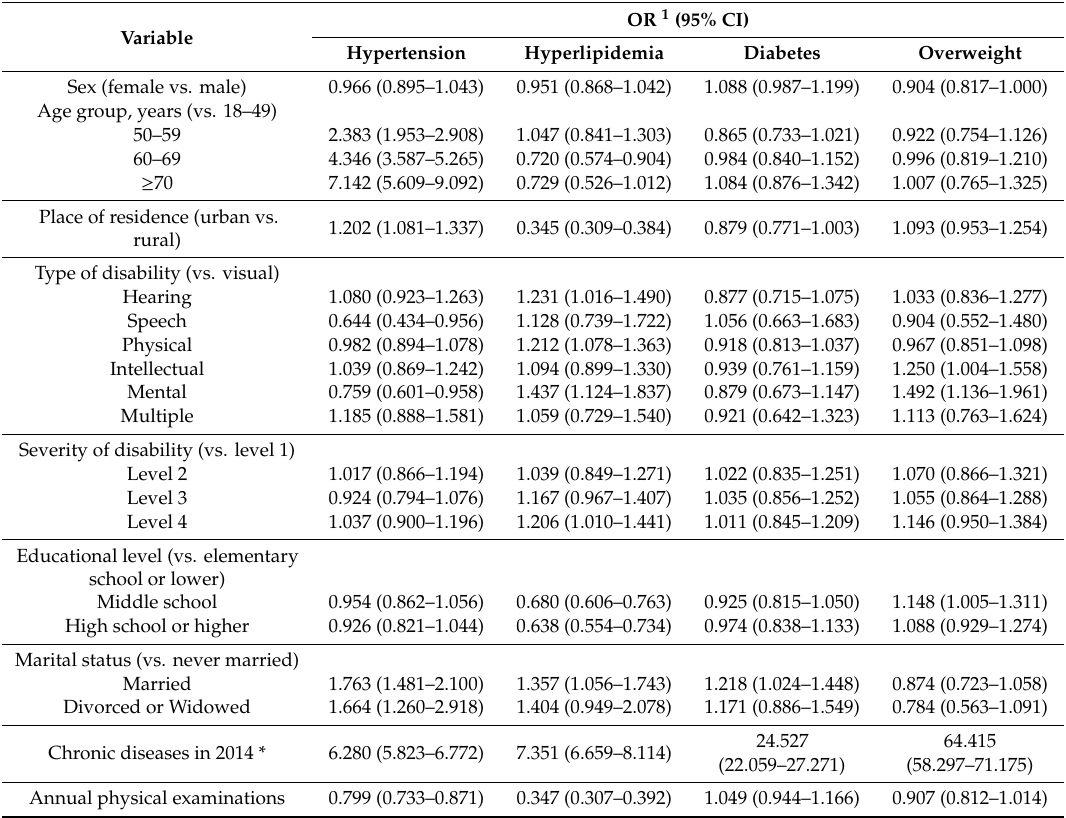
Table 2. Analysis of risk factors for chronic noncommunicable